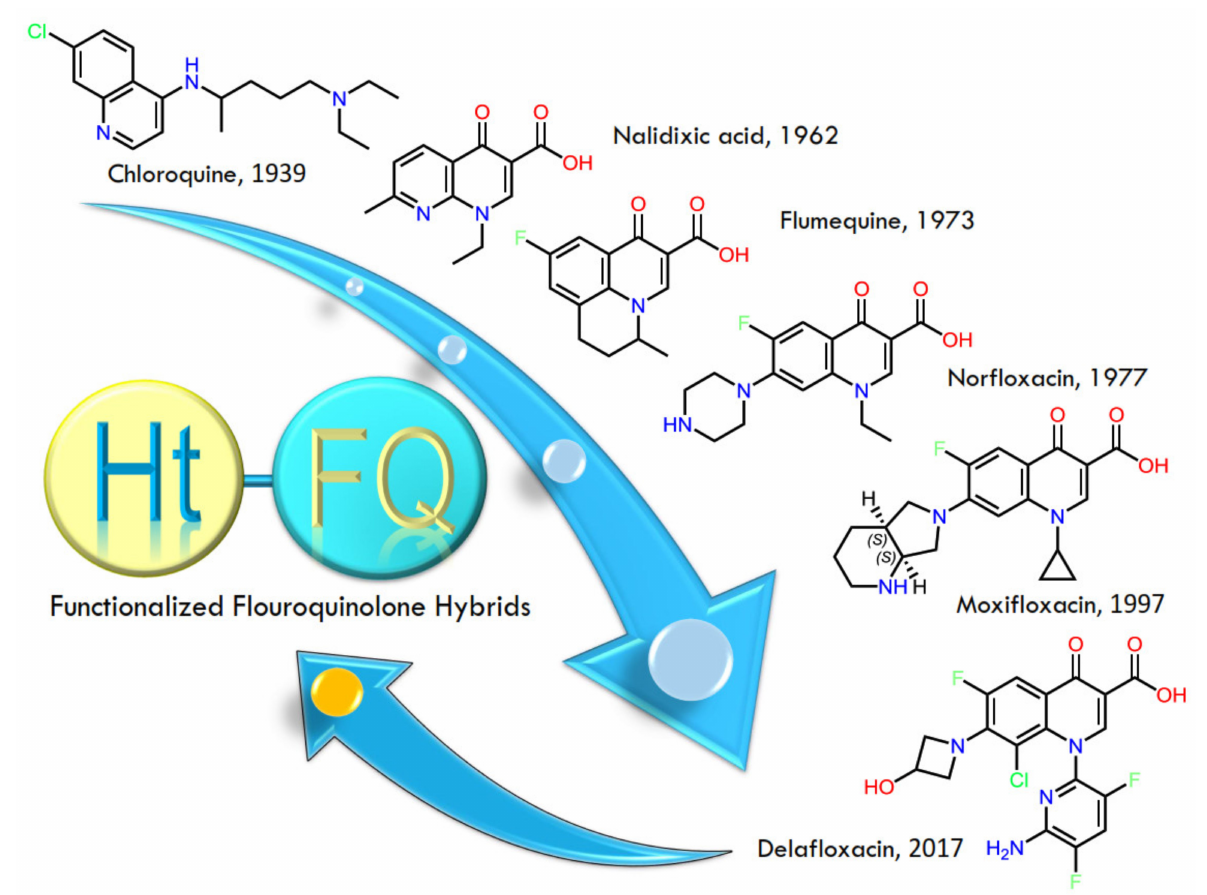
Figure 1. Evolutionary trends of quinolone